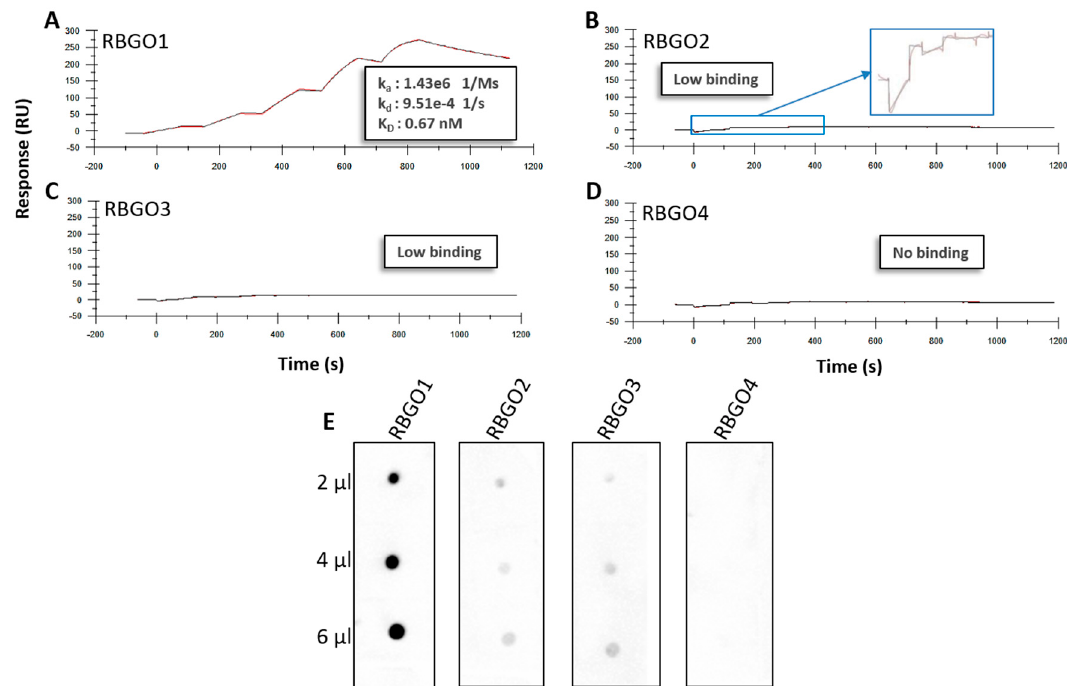
Figure 2. RBGO1 has a higher binding affinity (K D ) to full-length Receptor for Advanced Glycation End Products (RAGE) protein than RBGO2, RBGO3, and RBGO4. ( A–D ) Antibodies were captured to a Sensor Chip CM5 via an amine coupled anti-mouse antibody followed by single-cycle kinetics experiments. RBGO1 ( A ), RBGO2 ( B ), RBGO3 ( C ) or RBGO4 ( D ) antibodies were exposed to recombinant RAGE (2.5 to 200 nM) and data were fitted using a one-to-one Langmuir binding model. Displayed sensorgrams and overlapping fittings are exemplars from three independent experiments and the data shown are the mean. ( E ) Full-length, recombinant RAGE (at the volumes displayed) at 100 µ g/mL was immobilized onto activated polyvinylidene difluoride (PVDF) membrane and probed with each of the four α -RAGE antibodies (1 µ g/mL). Images were acquired using a Gel-Doc Image acquisition system.